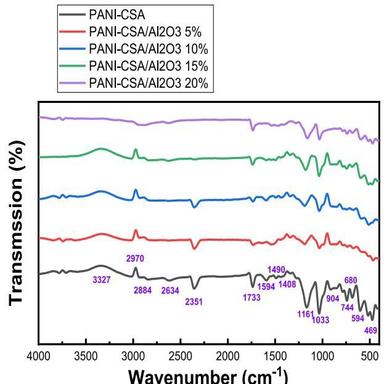
FTIR spectra of PANI and PANI-Al2O3 nanocomposite films.